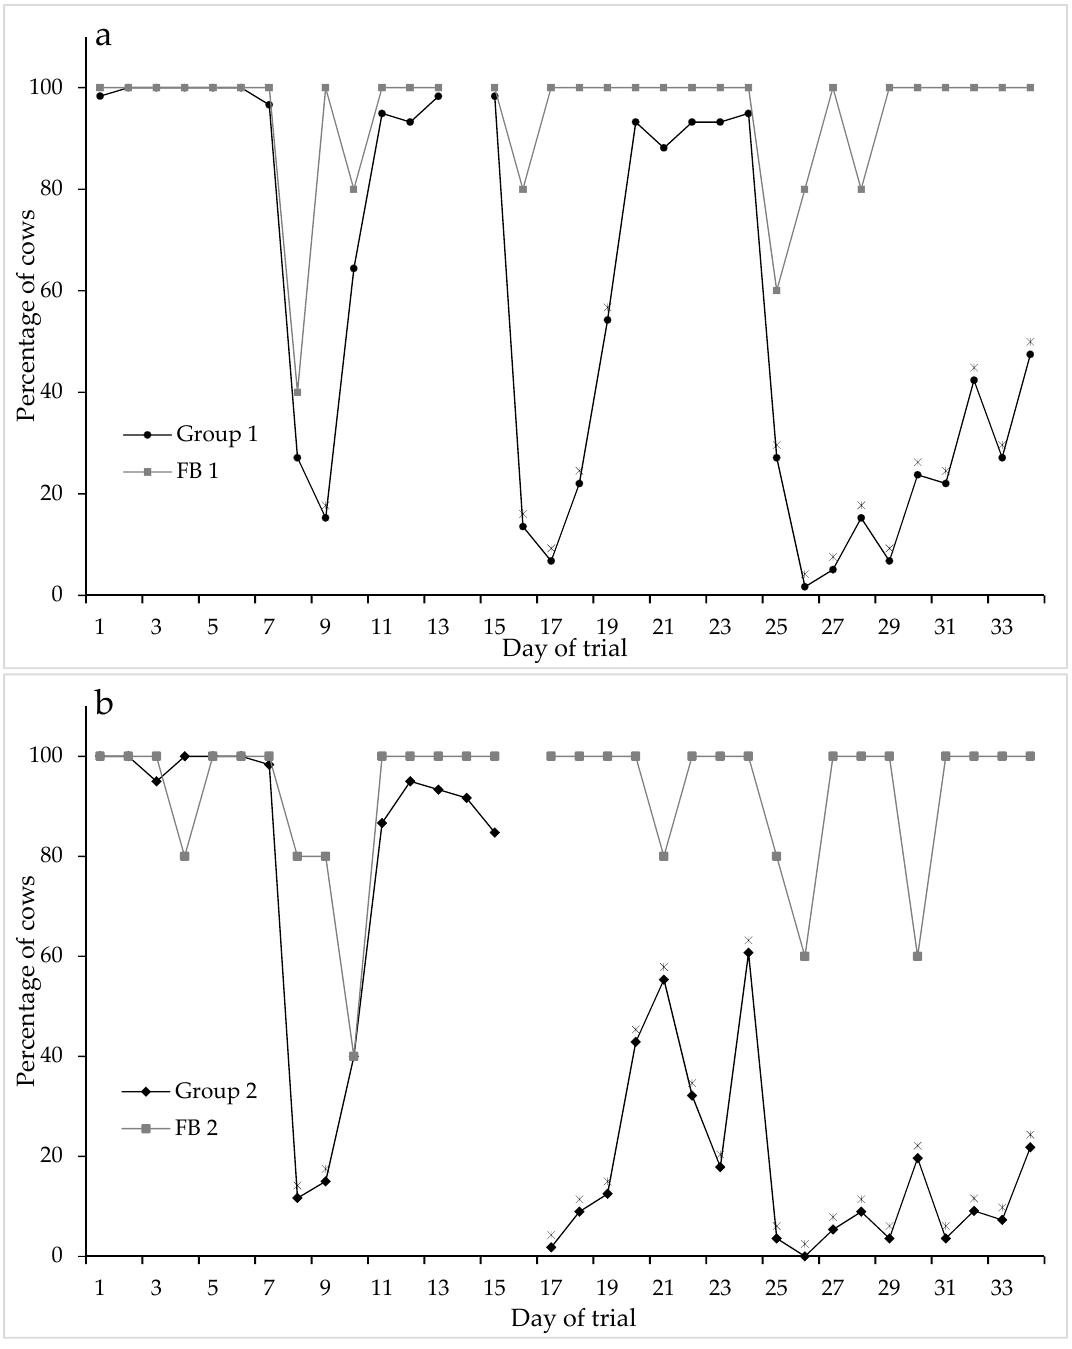
Figure 2. Percentage of cows that achieved at least 8 h lying per day, for NFP Group 1 and FB 1 ( a ) and NFP Group 2 and FB 2 ( b ) (* indicates significance, p < 0.05, between the groups at each time point) over the five weeks of the trial. (Data logger change over days were excluded from the data). The decline in daily lying time was mainly driven by a decline in lying time on the pad. For NFP Group 2 (and to a lesser extent NFP Group 1), the time spent lying in the paddock increased after approximately two weeks, however, this did not compensate for the reduction of time spent lying on the pad. The percentage of time spent lying on the pad declined from over 65% in week 1 to less than 30% in week 5 (Figure 3). At the same time, the percentage of time lying in the paddock increased, reaching 15% of time in the paddock in the last week of the trial (Figure 3). The effect was most marked during the first three hours on pasture, when less than 10% of cows were lying, at the start of the trial, and throughout the five weeks for the FB groups. However, in the last week of the trial, more than 40% of the cows were lying down during the first three hours in the paddock.